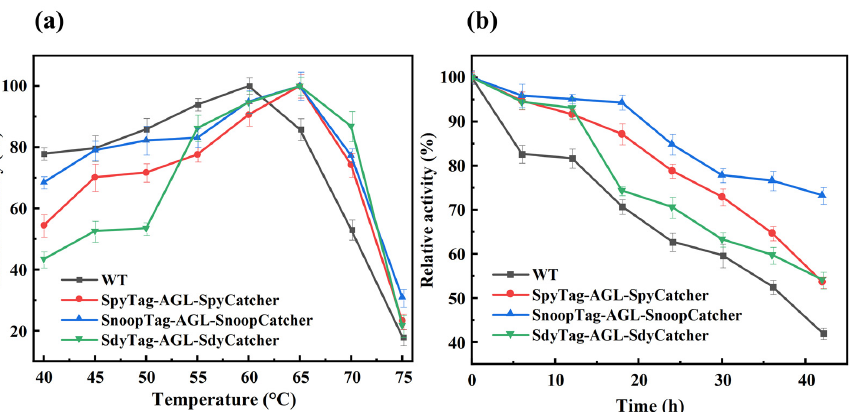
Figure 5. Effects of temperature on the activity and stability of wild-type and cyclized AGL: ( a ) optimal temperature, ( b ) thermal stability at 65 °C. All assays were performed in triplicate, and the standard deviations of biological replicates are indicated by error bars.